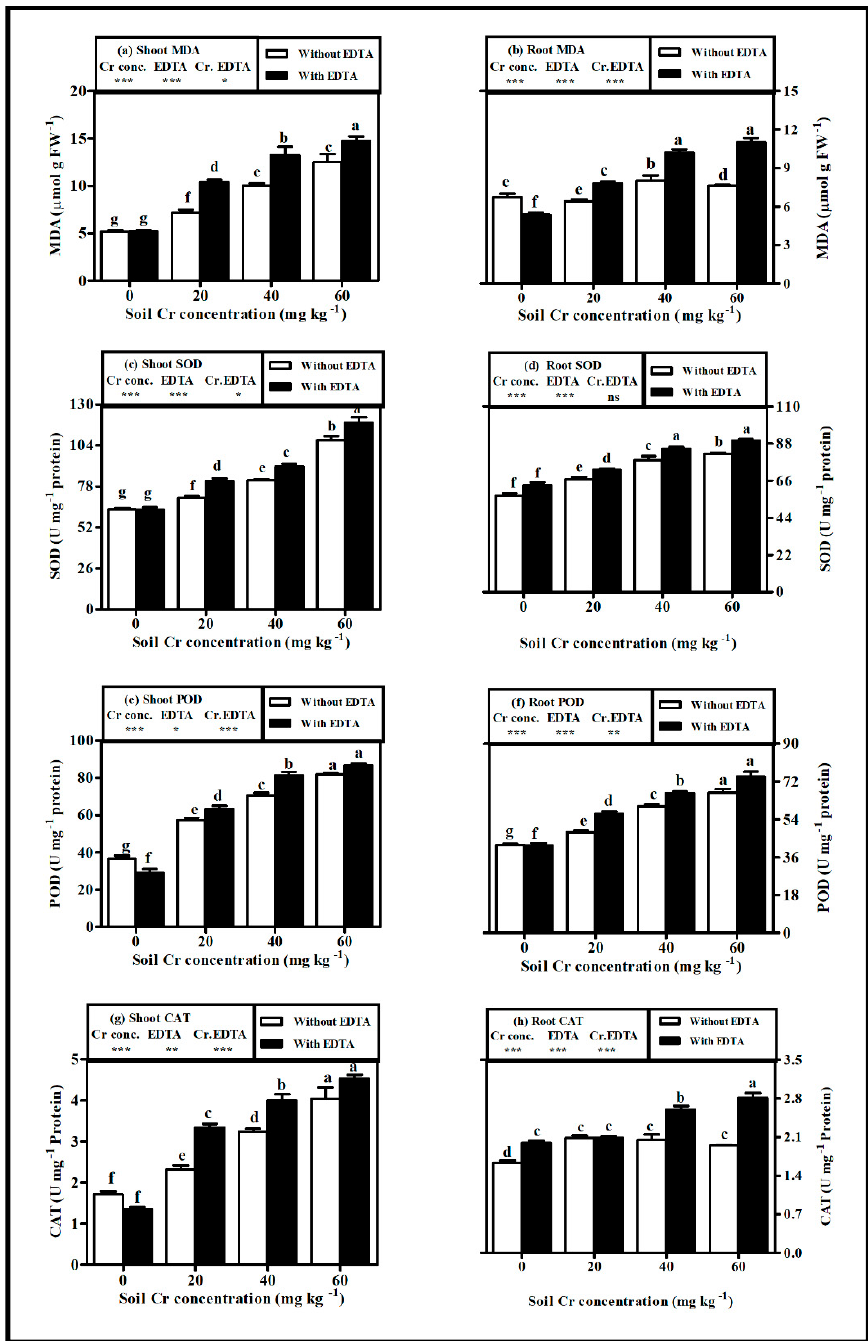
Figure 4. Influence of various Cr(VI) concentrations in soil on ( a ) malondialdehyde (MDA) level in shoot, ( b ) MDA level in root, ( c ) superoxide dismutase (SOD) activity in shoot, ( d ) SOD activity in root ( e ) peroxidase (POD) activity in shoot, ( f ) POD activity in root ( g ) catalase (CAT) activity in shoot and ( h ) CAT activity in root of hybrid Napier grass with and without EDTA application. Bars with dissimilar letters are significantly different at p < 0.05 from Tukey’s test. Values are means ± SE, n = 5. * p < 0.05; ** p < 0.001; *** p ≤ 0.001. ns: non-significant, Cr conc.: soil Cr(VI) concentration effect; EDTA: EDTA e ff ect and Cr conc. EDTA: Cr(VI) conc. × EDTA interaction e ff